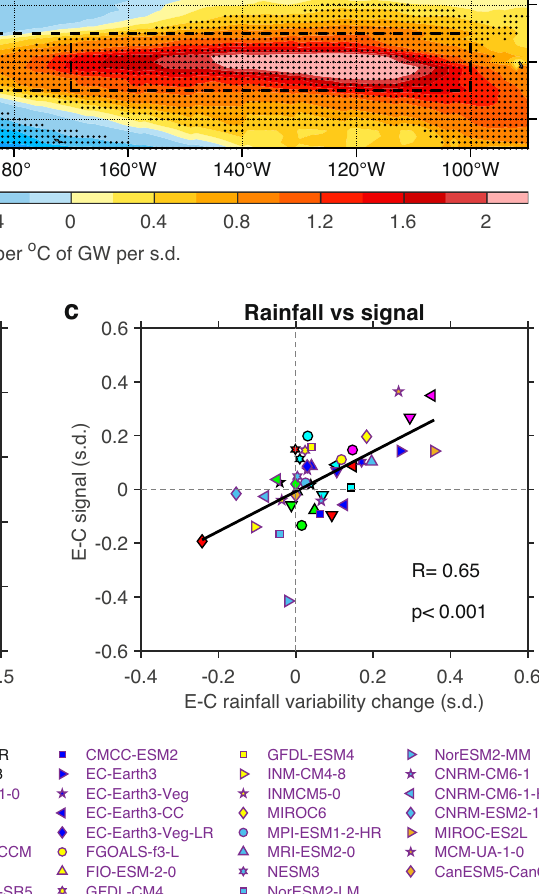
The zonal warming contrast is de fi ned as SST warming difference between the eastern (170°W – 100°W, 5°N – 5°S) and western (120°E – 170°W, 5°N – 5°S) equatorial Paci fi c (dashed boxes in a ). EP (CP)-ENSO rainfall is diagnosed at centres by regression of anomalous rainfall onto E-index (C-index) over the whole period in each model (see text for details). c Inter-model relationship between E-minus-C rainfall variability change and E-minus-C signal difference. The linear fi ts (solid lines) are displayed in b , c together with correlation coef fi cient R and corre- sponding p -value. Results shown hereare based ontheRCP85/SSP585scenario for a future warming climate, focusing on the 60 – 80-year